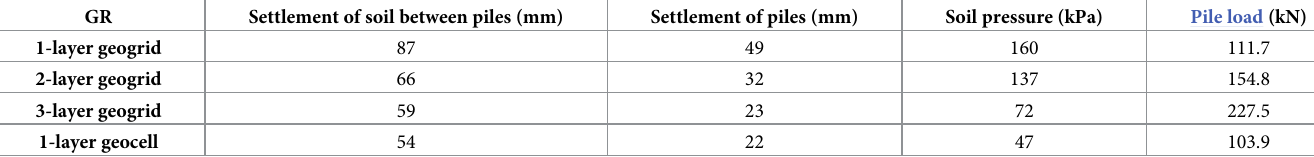
Table 5. Settlements of piles and soil between piles, and soil pressure under different GR configurations.